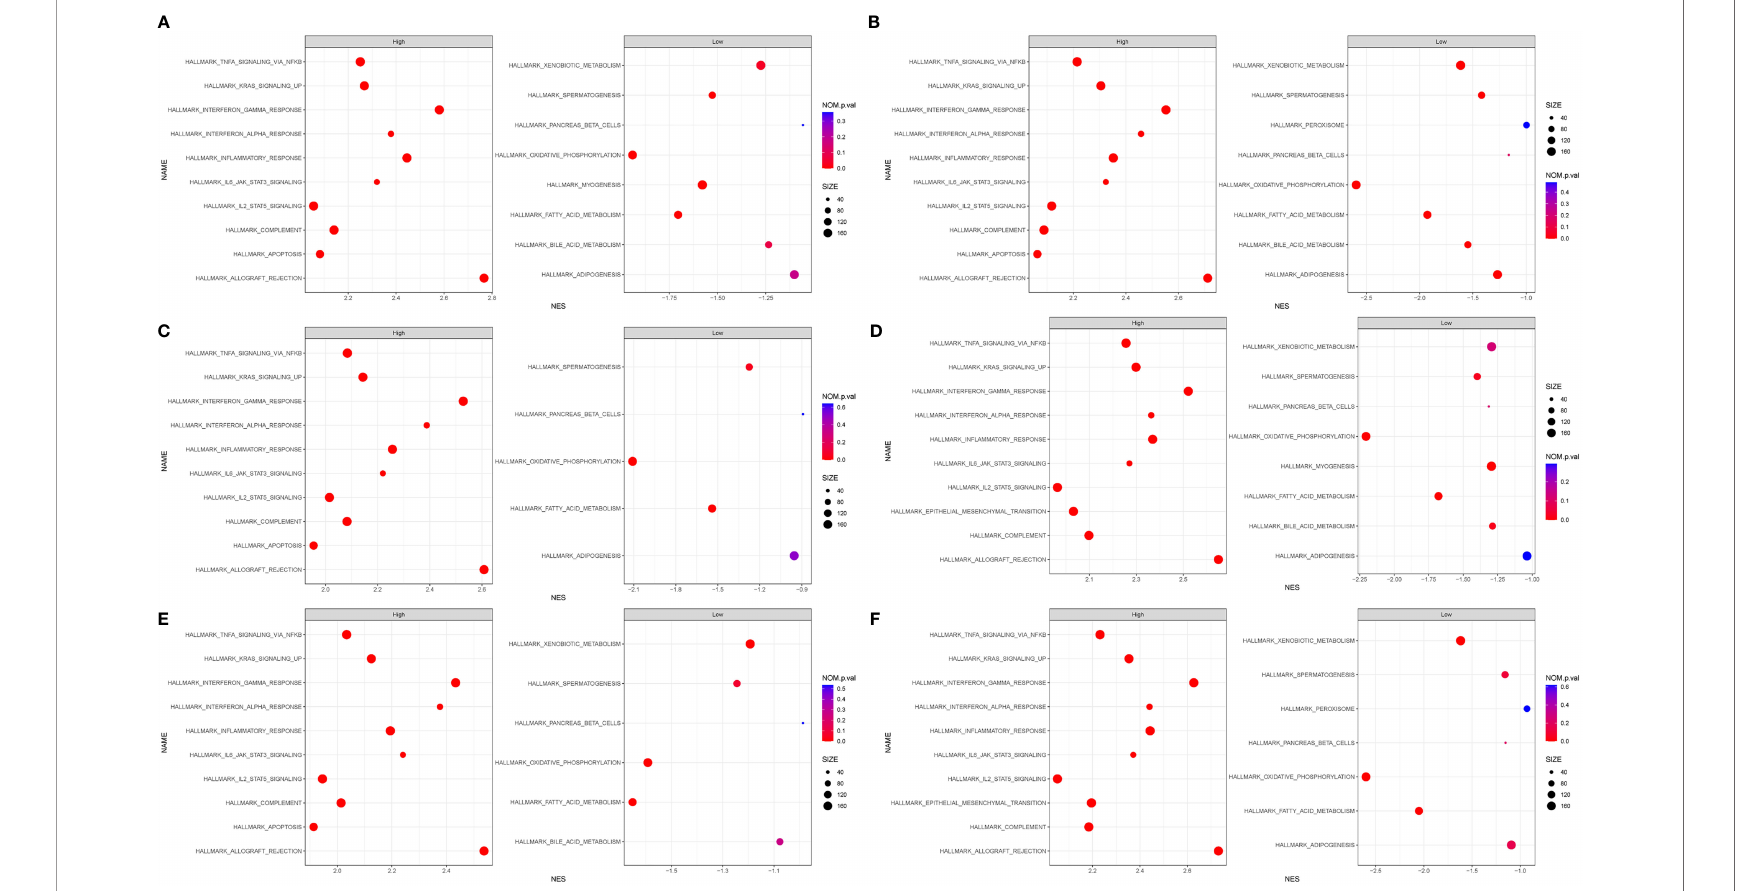
FIGURE 7 | Gene set enrichment analysis (GSEA). The full list of gene sets enriched in samples with DOCK2 (A) , NCKAP1L (B) , IL2RG (C) , SLAMF8 (D) , CD180 (E) , and PTPRE (F) highly